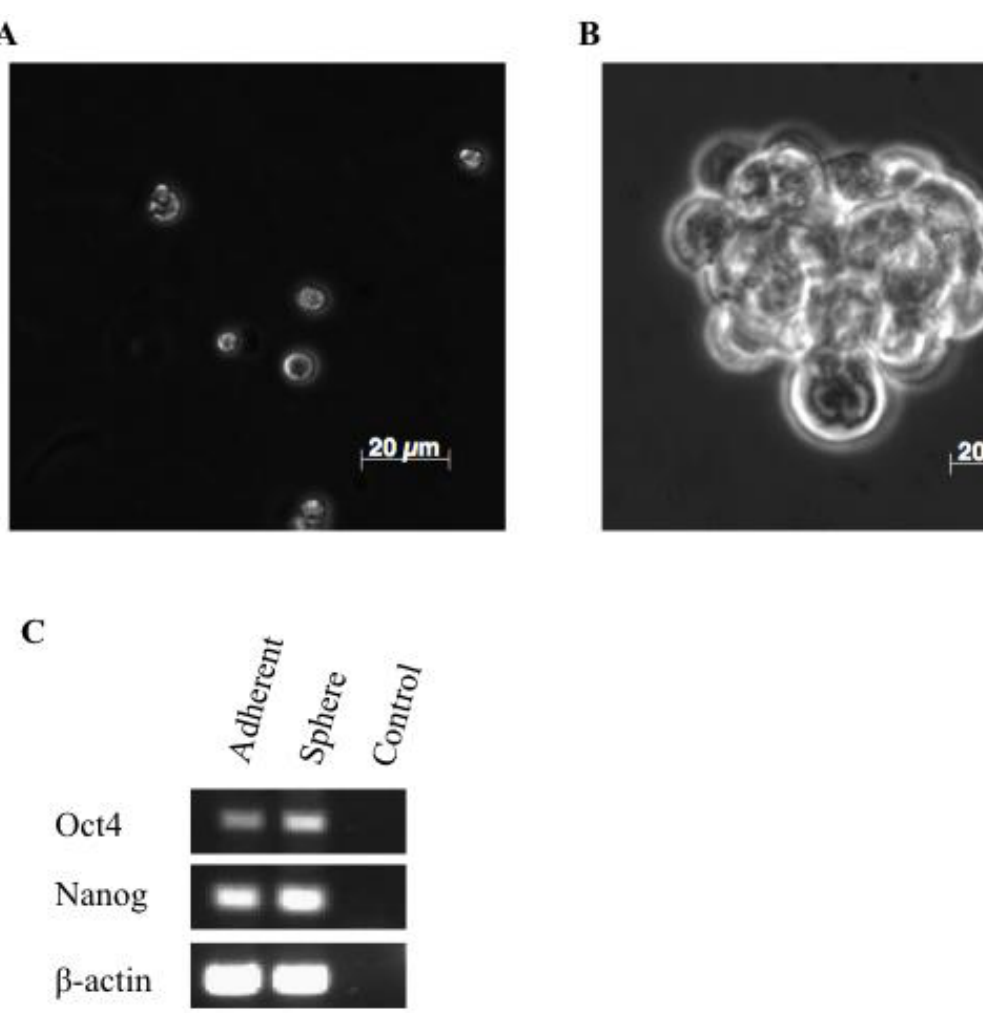
Figure 1. Isolation and characterization of putative cancer stem cells. Tumorsphere formation from the REM134 canine mammary carcinoma cell line. Single cells (A) and sphere (B). Non-quantitative RT-PCR analysis of mRNA expression of the embryonic stem cell markers Oct4 and Nanog